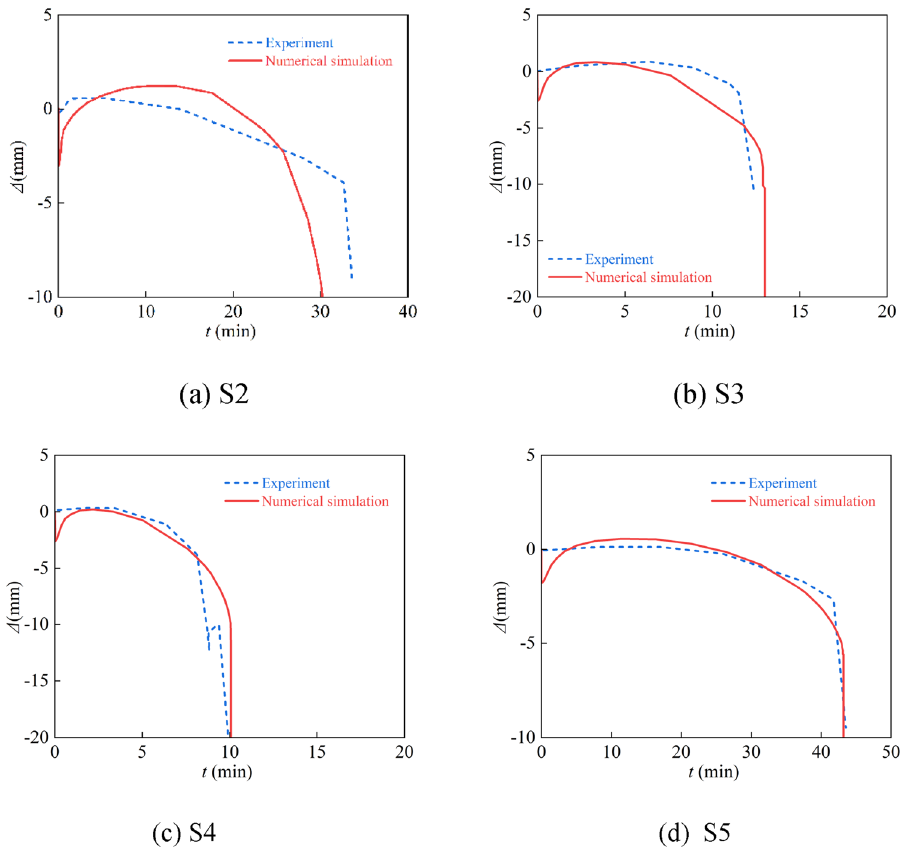
Figure 4. Comparison of experimental and calculated curves.